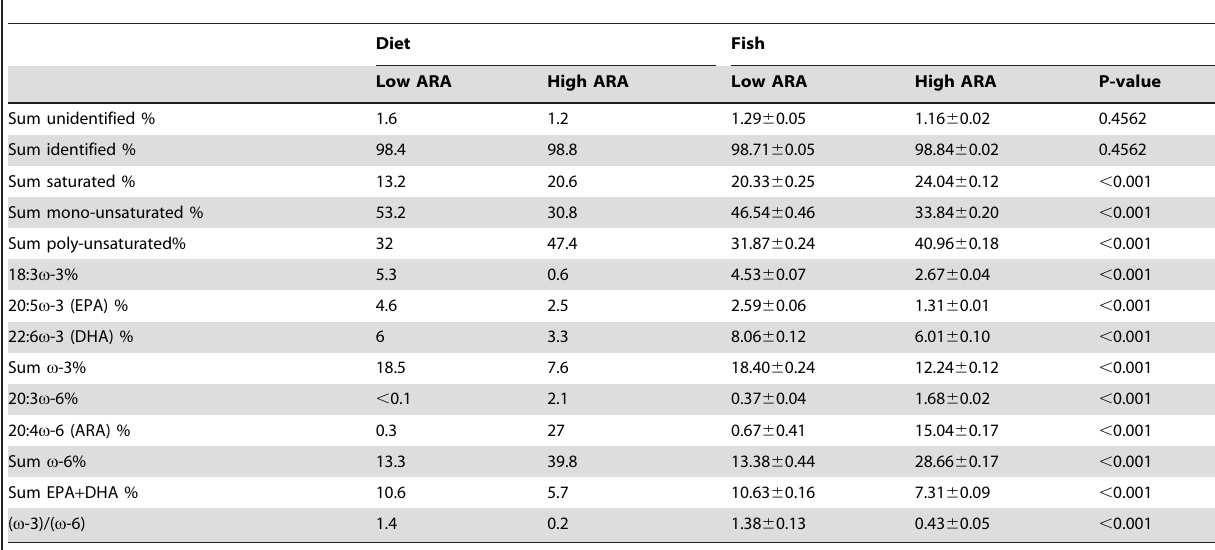
Table 2. Fatty acid profiles of the diets and of the zebrafish fed the respective diets for 6 weeks.